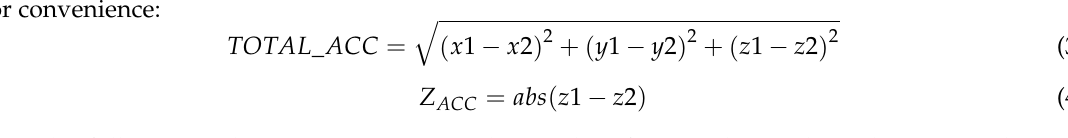
Table 5. Signal measurements of two sensors with digital processing on gentle motion.